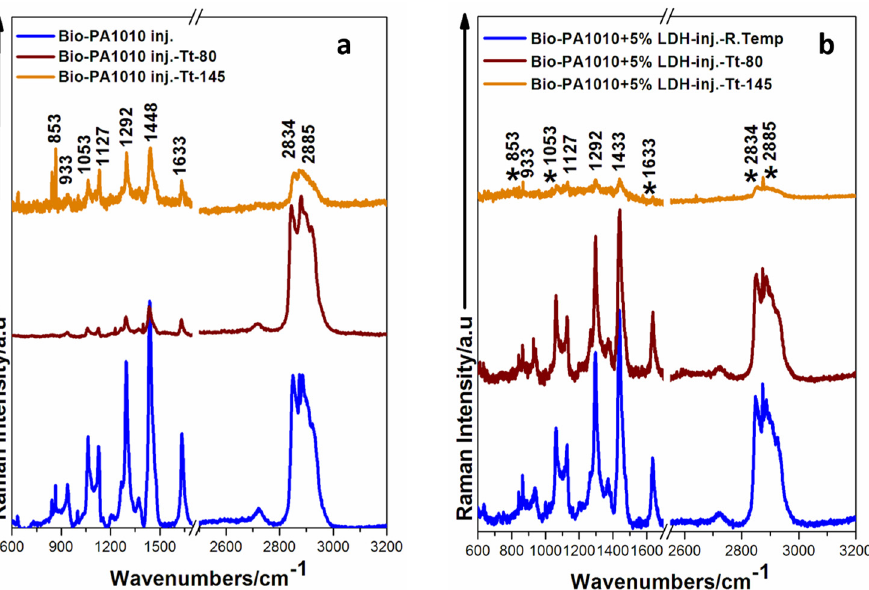
Figure 8. The Raman spectra of bio-PA1010 untreated and thermally treated at 80 ◦ C and 145 ◦ C ( a ) and bio-PA1010 filled with LDH-5% nanocomposites untreated and thermally treated at 80 ◦ C and 145 ◦ C ( b ). We marked with * the bands that are less visible after the thermal treatment.